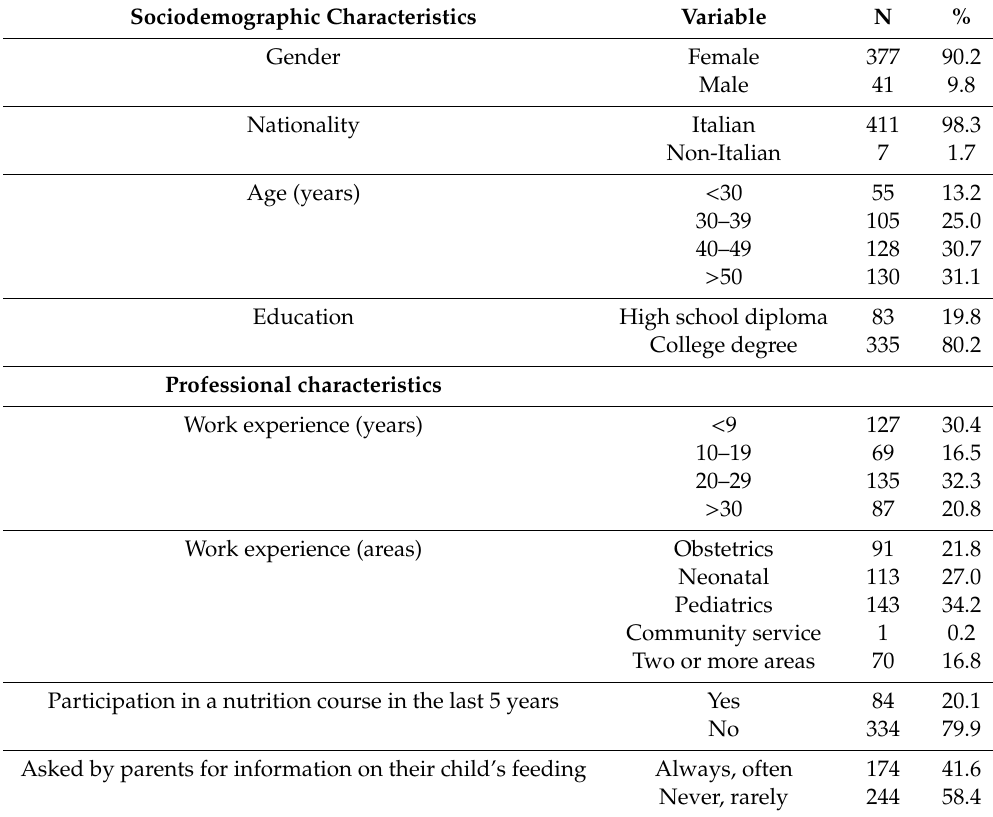
Table 2. Population characteristics.